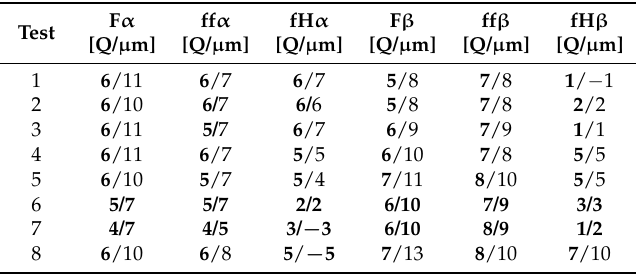
Table 8. Achieved gear qualities according to DIN3962 [18] for tests 1 to 8 of hard machining with standard inserts of type